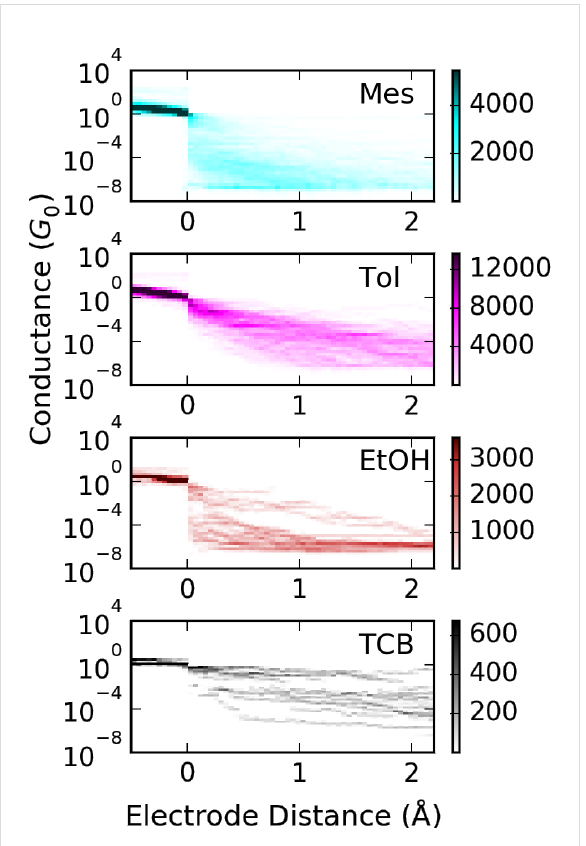
Figure 7: Two-dimensional histograms (density plots) of Au MCBJs in Mes, Tol, EtOH, and TCB calculated from stretching traces. The indi- vidual traces have been overlaid at a conductance of 0.5 G 0 . The numbers of curves are: Mes 649, Tol 186, EtOH, 26, TCB